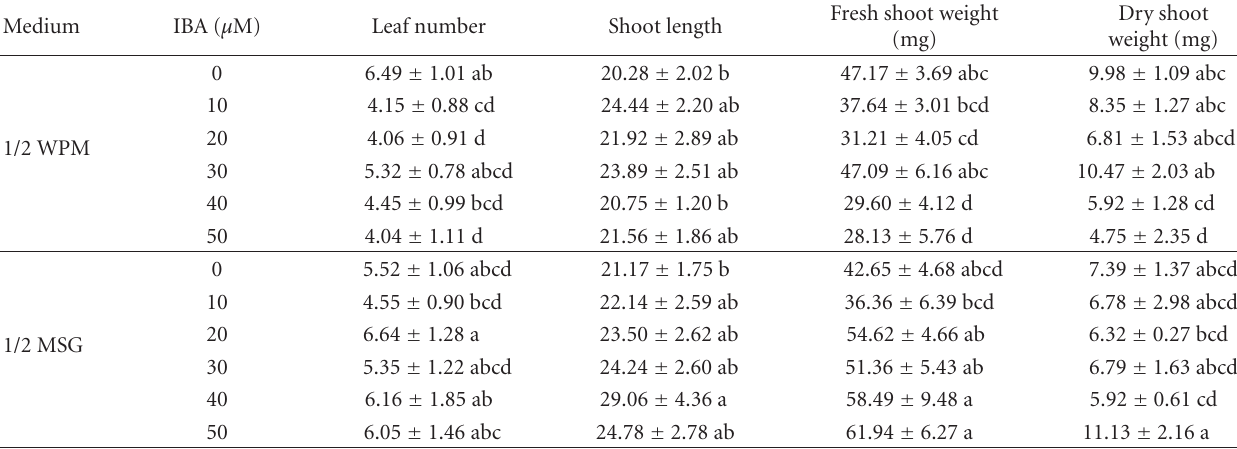
Table 5: E ff ect of indole butyric acid (IBA) concentration and di ff erent formulations of basic culture media (1/2 WPM and 1/2 MSG) on shoot development parameters of in vitro rooting of Handroanthus impetiginosus with three days of auxin pulse induction, after 40-day